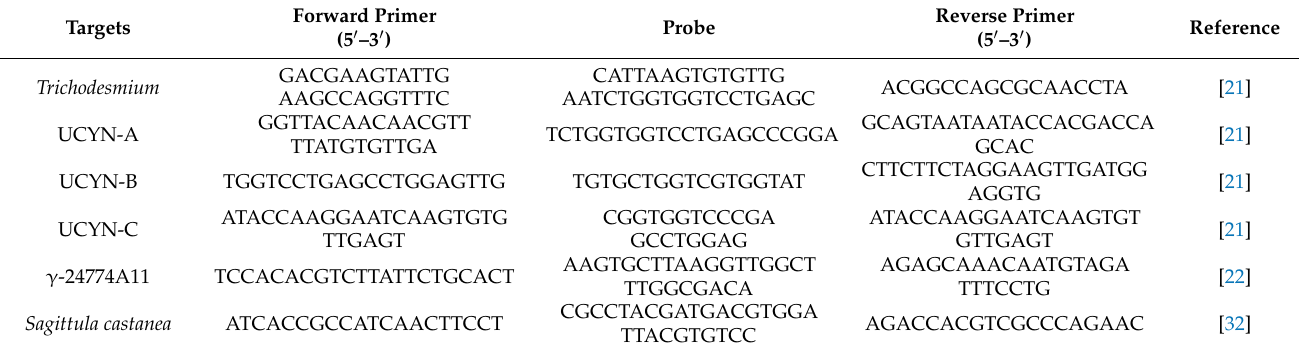
Table 1. Primers, Taqman probes, and standard clones for quantitative polymerase chain reaction (qPCR) analysis targeting nifH gene of different cyanobacterial diazotrophic groups. The 5 (cid:48) and 3 (cid:48) of TaqMan probes were labeled with the fluorescent reporter FAM (6-carboxyfluorescein) and the quenching dye TAMRA (6-carboxytetramethylrhodamine),